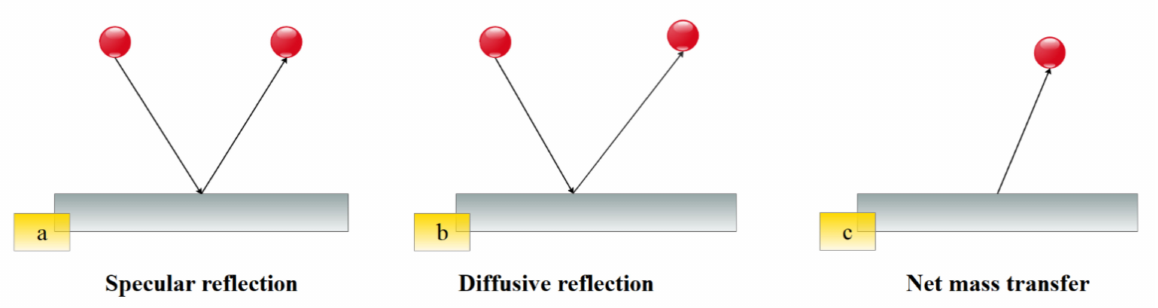
Figure 7. Wall-gas molecule interactions include ( a ) specular reflection of impinging gas molecules, ( b ) diffusive reflection of impinging gas molecules, and ( c ) net mass transfer at the wall owing to evaporation/condensation or wall porosity (Lin Wu [100]).